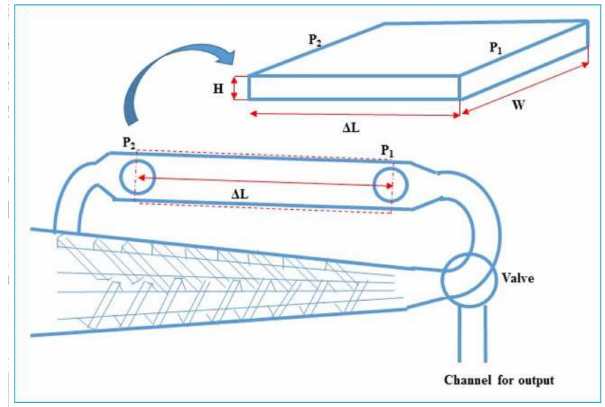
Figure 2. Schematic diagram of the portion of micro-compounder having a slit capillary back-flow channel, which can be used for rheological